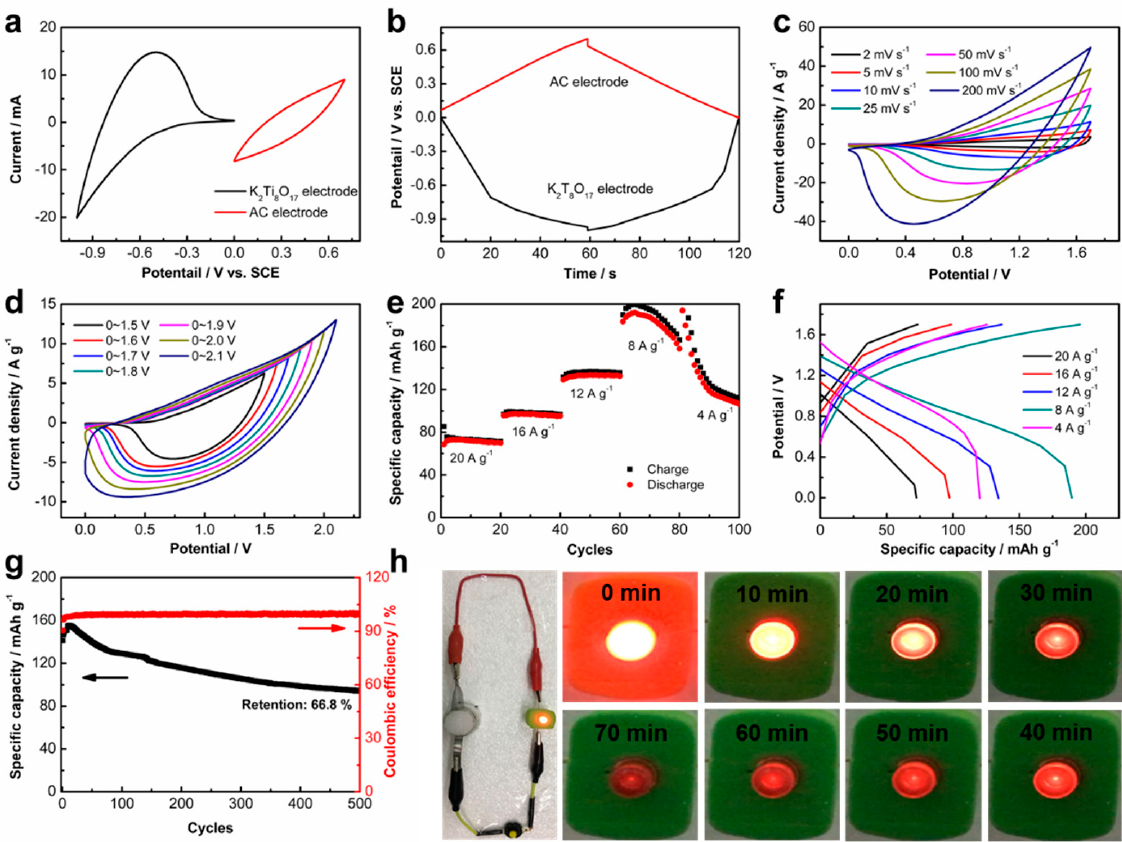
Figure 6. Electrochemical performance of AIB in the hybrid AlCl 3 /NaAc electrolyte: ( a ) CV curves of K 2 Ti 8 O 17 electrode at the potential range of − 1~0 V and AC electrode at the potential range of 0~0.7 V with a scan rate of 25 mV s − 1 ; ( b ) GCD curves of the K 2 Ti 8 O 17 electrode and AC-Ti electrode with the same current density of 20 A g − 1 at the potential range of 0~1.7 V; ( c ) CV curves of the K 2 Ti 8 O 17 //AlCl 3 /NaAc//AC-Ti at different scan rates; ( d ) CV curves of the K 2 Ti 8 O 17 //AlCl 3 /NaAc//AC-Ti with a scan rate of 25 mV s − 1 at different potential ranges; ( e ) specific capacitance of the K 2 Ti 8 O 17 //AC-Ti at different current densities; ( f ) GCD curves of the K 2 Ti 8 O 17 //AlCl 3 /NaAc//AC-Ti at different current densities; ( g ) cycling performance of the K 2 Ti 8 O 17 //AlCl 3 /NaAc//AC-Ti with the current density of 20 A g − 1 ; ( h ) digital photographs of the K 2 Ti 8 O 17 //AlCl 3 /NaAc//AC-Ti-lighted LED indicator, and the lightness of the LED indicator lasting for different periods.